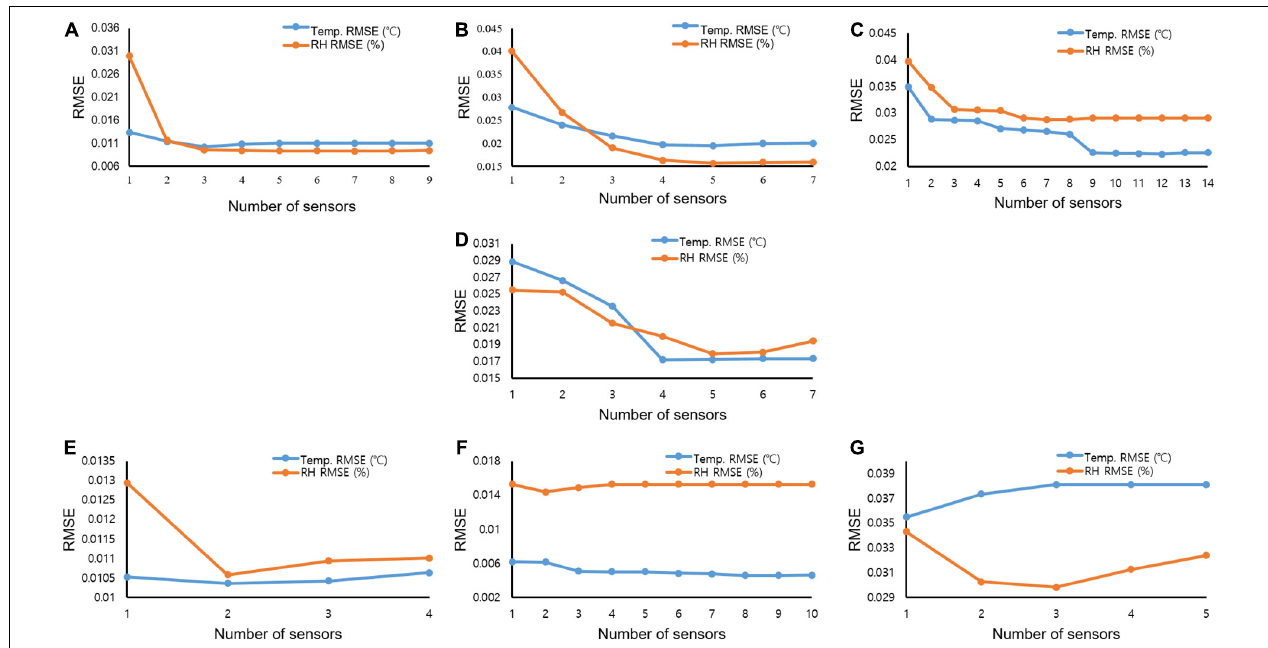
FIGURE 8 | Root mean squared error curves showing the reduction in error at different numbers of sensors using temperature and relative humidity data for (A) February; (B) March; (C) April; (D) May; (E) June; (F) July; and (G)